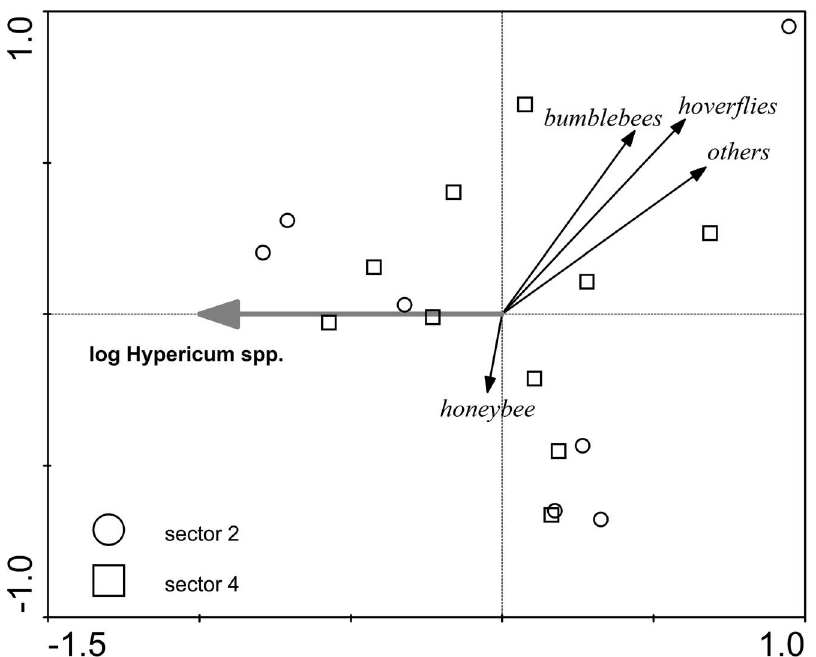
Figure 3. Ordination diagram of RDA of pollinator densities on Ranunculusacris . Environmental variables included in the final model, based on forward selection were: logarithm of flowering stalk abundance of Ranunculus acris (log R. acris), logarithm of flowering stalk abundance of Sanguisorba oficinalis (log S. officinalis), and 1 st axis of DCA of flowering plant composition (vegetation 1); plots were categorized according to the sector in which they were located(see Fig. 1 for definition of sectors); 1 st ordination axis explains 34.7% of total variability in pollinator density, 2 nd axis explains 15.2%.